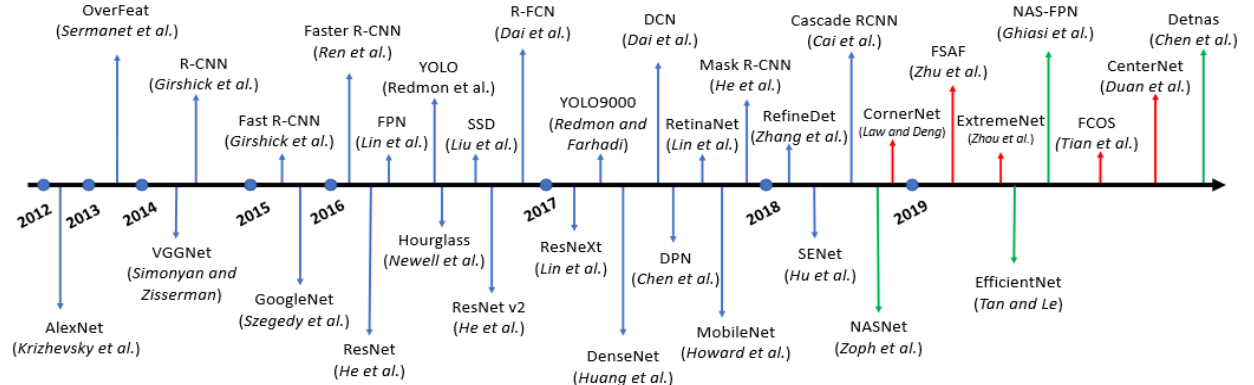
Figure 1. CNN-based target detection algorithm and network development map.